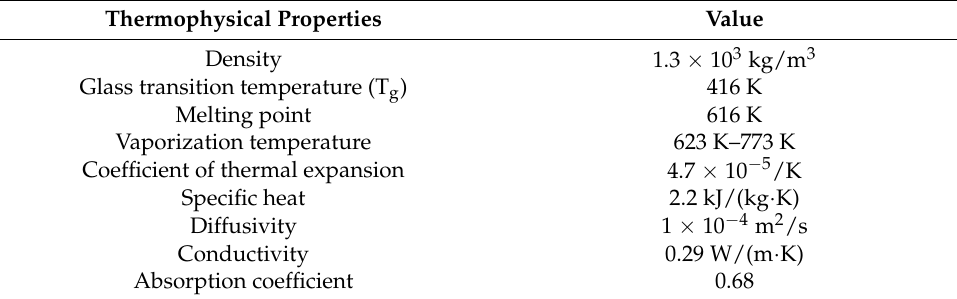
Table 1. Thermophysical properties of PEEK [22,33] .